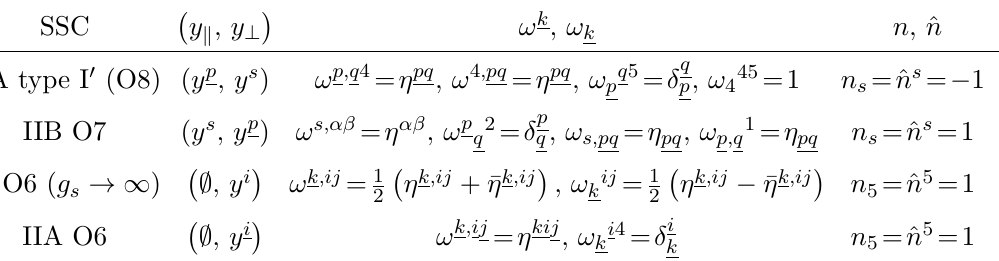
Table 7 . We list the only non-vanishing components of the basis forms ω k , ω k , n a and ˆ n a for SSCs in which the fixed point is less than 10-dimensional. The y which are tangent and transverse to the fixed point, respectively. The index p = 1 , 2 label tangent / transverse coordinates in the O8/O7 case.